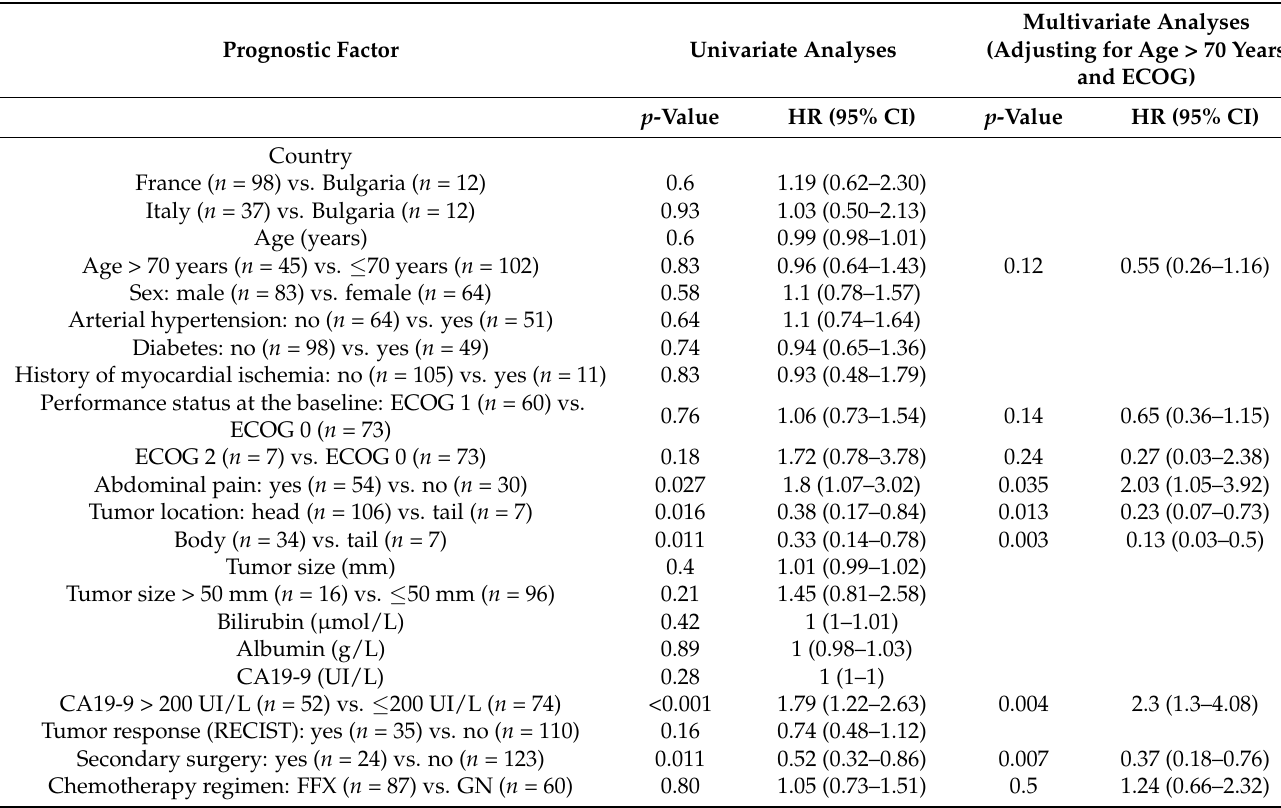
Table 3. Prognostic factors of the progression-free survival.